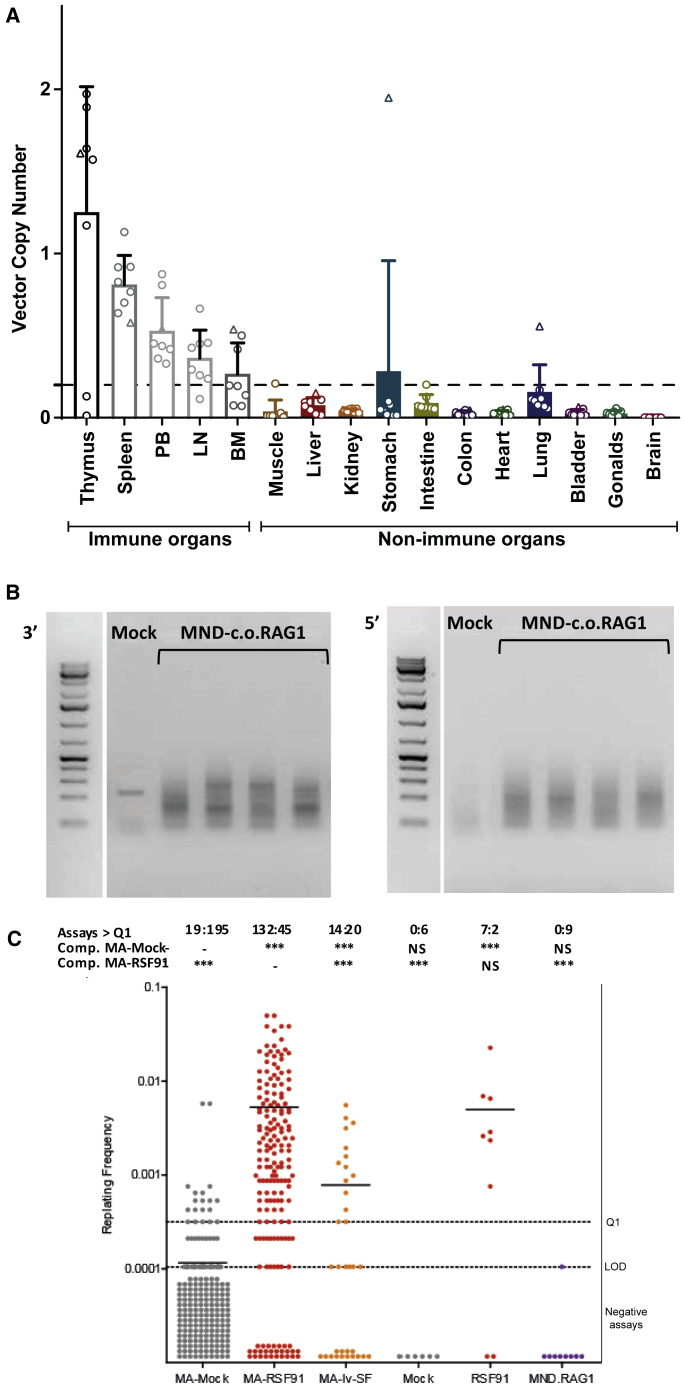
Preclinical Safety Testing of the Clinical-Grade MND-c.o.RAG1 Vector(A) Vector biodistribution in immune and non-immune organs assessed by qPCR on DNA samples from 16 organs in total. Each dot represents a value from one mouse (three mice/control group, eight MND-c.o.RAG1 mice). The horizontal dashed line represents the threshold of the VCN of immune organs versus non-immune organs (starting VCN of transplanted cells of 0.2). (B) LV insertion site analysis by nrLAM-PCR of isolated DNA from BM obtained from Rag1−/− untransduced control mouse (mock) and four MND-c.o.RAG1 mice (male non-immunized/immunized, female non-immunized/immunized). Gels shows results of the linear amplification from the 3′ long terminal repeat (LTR) and 5′ LTR, respectively (L = 1 kb plus marker). (C) Replating frequencies (RFs) of the control samples mock or RSF91 and the test vector MND-c.o.RAG1, in comparison to data of a meta-analysis for control samples (Mock-MA, RSF91-MA, lv-SF-MA [a lentiviral vector with an SFFV promoter]). The data points below the limit of detection (LOD; plates with no wells above the MTT threshold) were manually inserted into the graph (due to the logarithmic scale of the y axis). Above the graph, the ratios of positive (left number) and negative plates (right number) according to the MTT assay are shown. Differences in the incidence of positive and negative assays relative to Mock-MA or RSF91-MA were analyzed by Fisher’s exact test with a Benjamini-Hochberg correction (∗p < 0.05, ∗∗p < 0.01, ∗∗∗p < 0.001; NS, not significant). If above the LOD, bars indicate the mean RF.